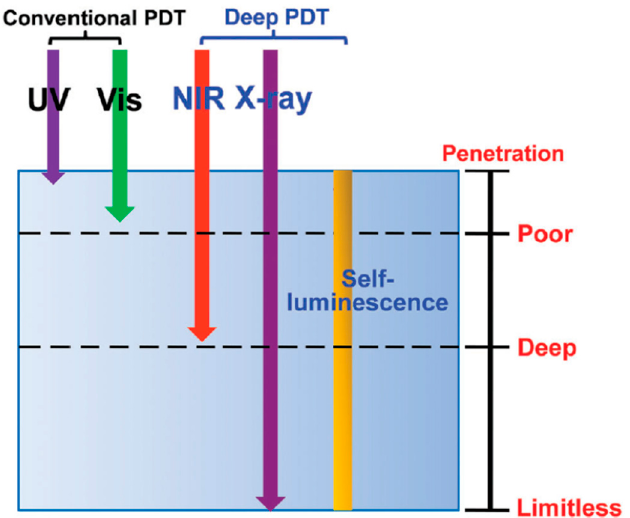
Figure 1. Comparison of tissue penetration of different excitation sources. Reprinted with permission from reference [35]. Copyright 2016 Royal Society of